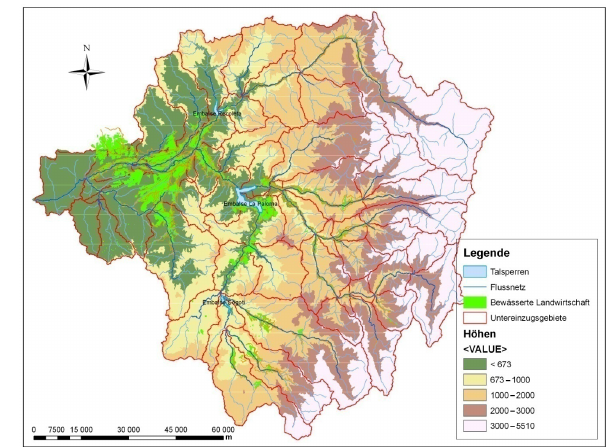
Figure 1. Limarí river basin (created by Kretschmer,